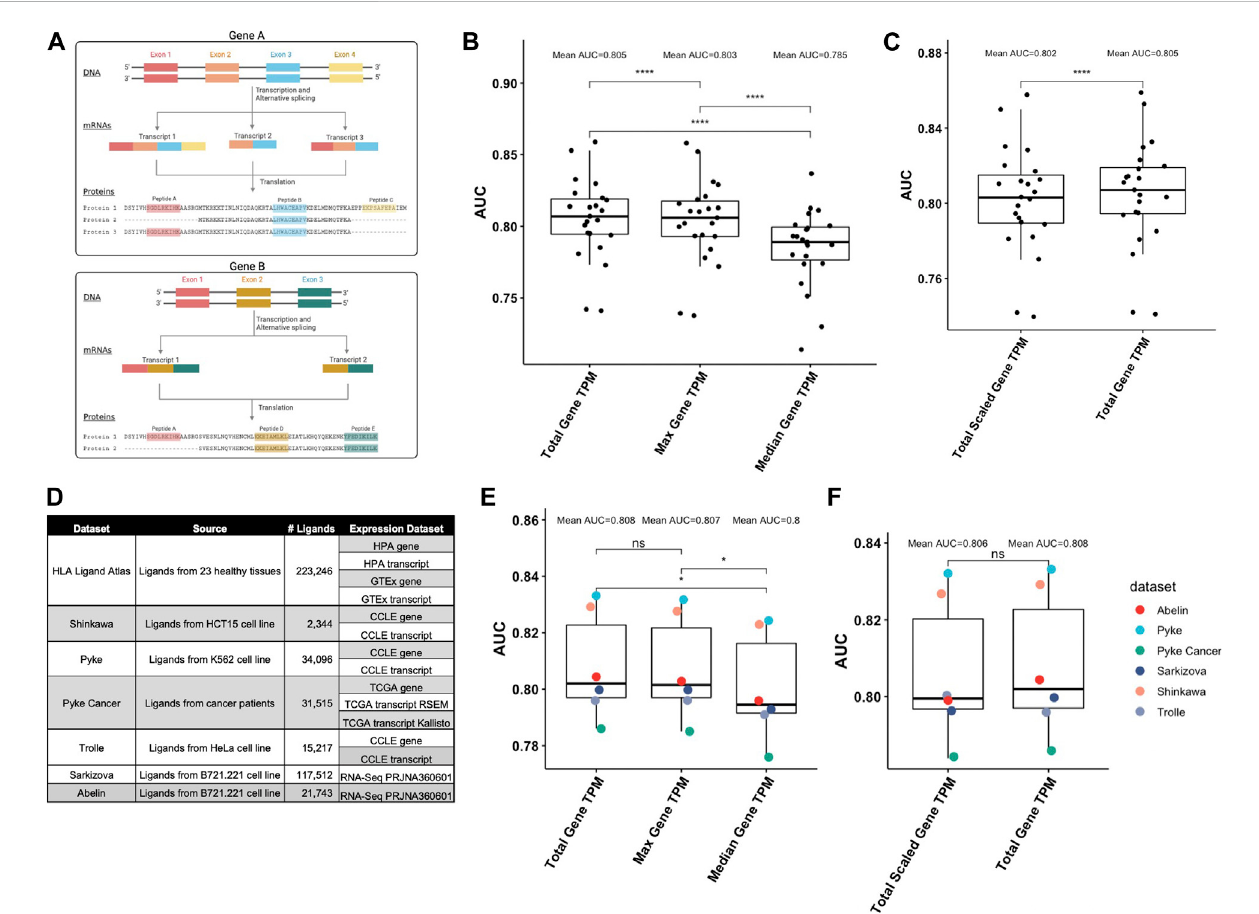
FIGURE 3 Considerations for retrieving peptide abundance levels. Due to alternative splicing, genes can produce multiple different proteins. (A) The different protein sequences usually share amino acid stretches encoded by the same exons. It is also possible, that different genes share amino acid stretches, particularlygenesfromthesamegenefamily.PeptideA(highlightedinred)forexamplecanberetrievedfromtwoproteinsofGeneAandfromoneproteinof Gene B, while Peptide B (highlighted in blue) can be retrieved from three proteins of Gene. (B) . Performance comparison of different ways to aggregate TPM values of multiple source proteins in distinguishing ligands of the HLA Ligand Atlas from decoy peptides. Summing up TPM values (total TPM) from all genes a peptide can be retrieved from performs best, followed by using the maximum TPM of all genes (Wilcoxon Test, p ≤ .0001). (C) . Performance comparisonofscalingtheTPMvaluesconsideringthenumberofproteinsageneencodesandthenumberofproteinsapeptideoccursinforligandsfromthe HLA Ligand Atlas. The total TPM signi fi cantly outperformed the total scaled TPM values (Wilcoxon Test, p ≤ .0001). (D) . Ligand elution datasets used in this study and the expression datasets we used to retrieve abundance levels. (E) . Performance comparison of different ways to aggregate TPM values of multiple source proteins in distinguishing ligands of the six validation datasets from decoy peptides. (F) . Performance comparison of total TPM and total scaled TPM proteins in distinguishing ligands of the six validation datasets from decoy